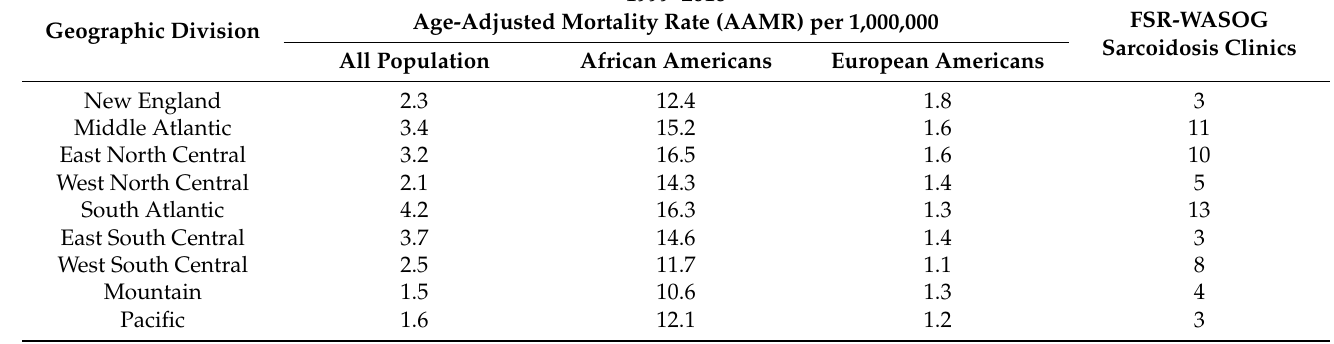
Table 2. Summary of Sarcoidosis-Related Age-Adjusted Mortality Rate and FSR-WASOG Sarcoidosis Clinics of 9 Geographic